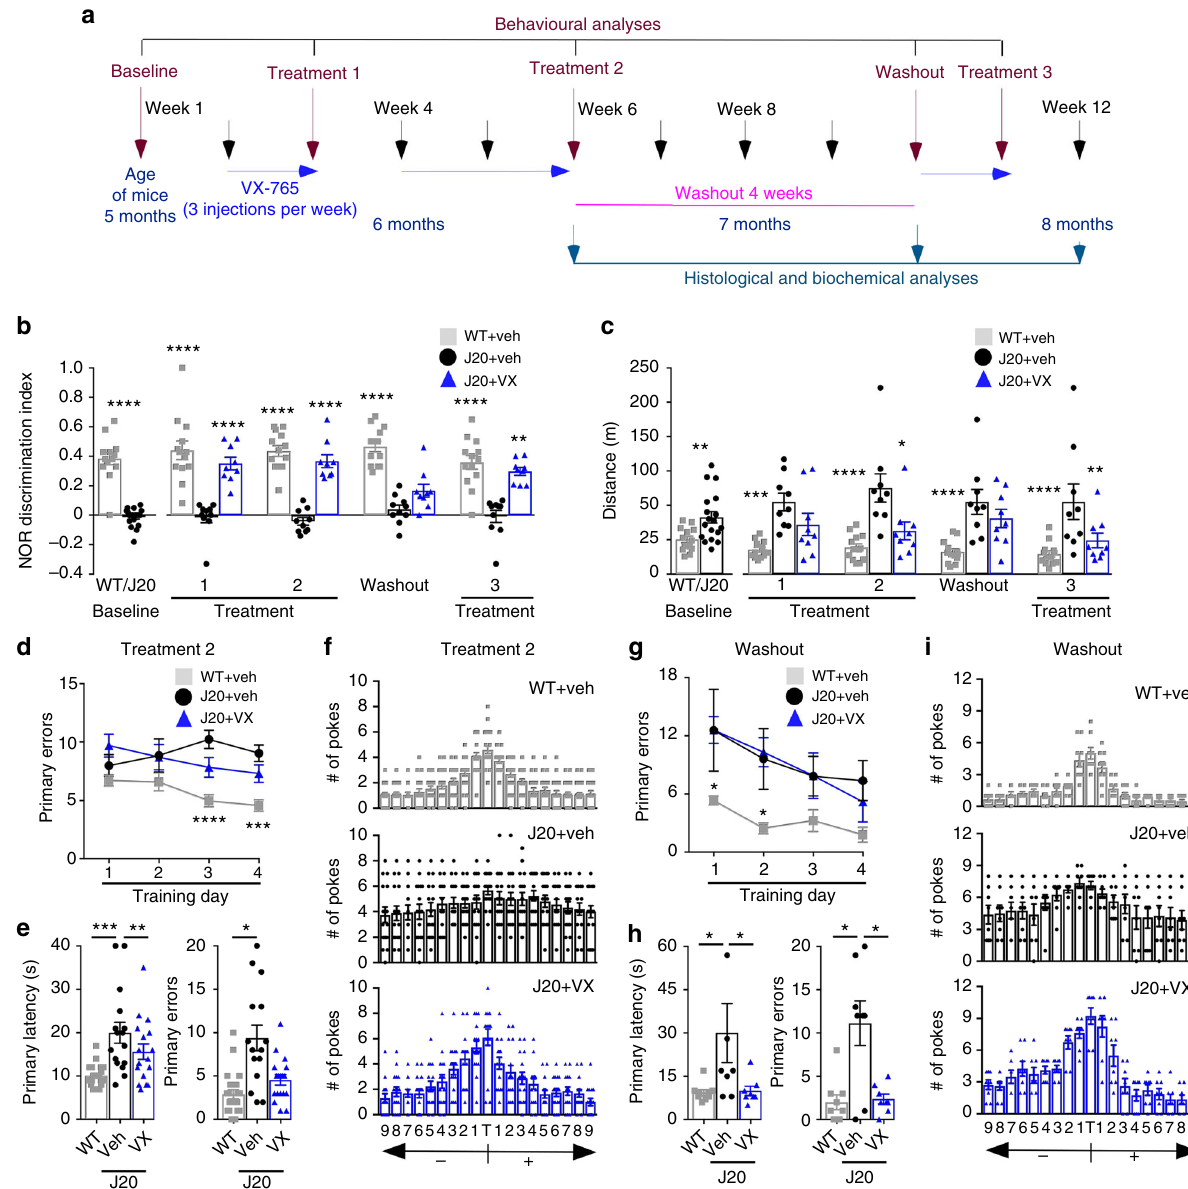
Fig. 1 VX-765 treatment restores J20 mice cognitive function. a Experimental treatment paradigm. b NOR Discrimination index from vehicle-treated WT (grey squares), vehicle-treated J20 (black circles) and VX-765-treated J20 (blue triangles). Each mouse tested is represented by one symbol. Data represent mean and s.e.m. (Treatment, F(2,20) = 85.8, p < 0.0001; Time, F(4,80) = 4.188, p = 0.0039; Treatment × Time, F(8,80) = 3.599, p = 0013). c Distance travelled during open fi eld task (Treatment, F(2,19) = 11.47, p = 0.0005; Treatment × Time, F(8,76) = 5.69, p < 0.0001). b , c Two-way repeated- measures ANOVA and Dunnett ’ s post-hoc versus J20 + vehicle, * p < 0.05, ** p < 0.01, *** p < 0.001, ****p < 0.0001. d – i Barnes maze: learning acquisition # of primary errors during d T2 (Treatment, F(2,212) = 19.93, p < 0.0001) and g WO (Treatment, F(2,56) = 10.86, p = 0.001; Training day, F(3,56) = 3.392, p < 0.0241). d , g Two-way repeated-measures ANOVA and Dunnett ’ s post-hoc versus J20 + vehicle * p < 0.05, *** p < 0.001, **** p < 0.0001. Probe primary latency and errors during e T2 and h WO. Target preference: # of pokes of each hole labelled + 1 to + 9 to the right or − 1 to − 9 to the left of the target (T) during the probe after f T2 and i WO (T2 primary latency, F(2,52) = 5.879, p = 0.0050; T2 primary errors, F(2,52) = 9.998, p = 0.0002; WO primary latency, F(2,22) = 4.076, p = 0.0312; WO primary errors, F(2,22) = 10.84, p = 0.0005). e , h ANOVA, Tukey ’ s post-hoc, * p < 0.05, ** p < 0.01, *** p <